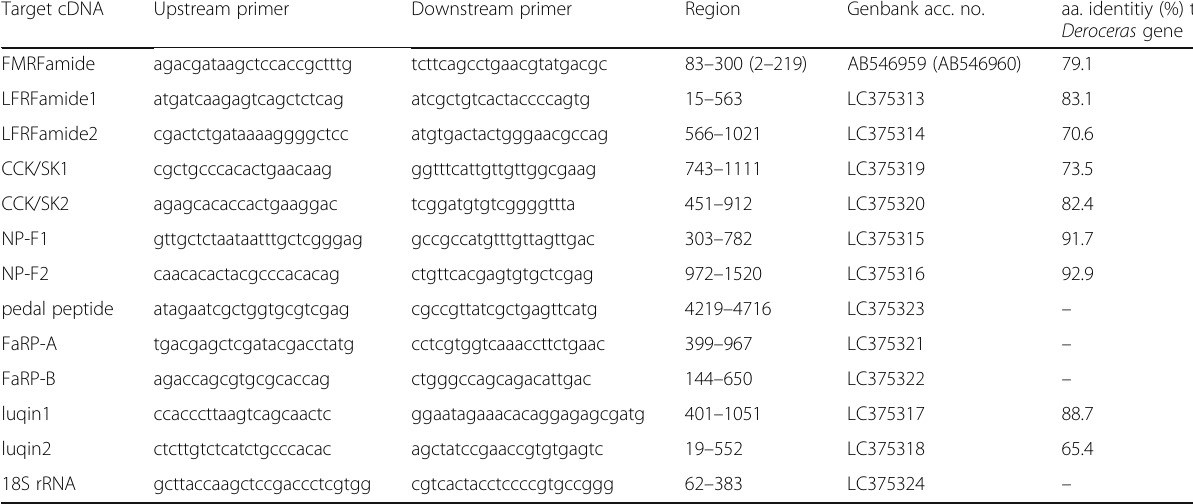
Table 1 PCR primers used for the expression analysis and the preparation of the templates for the cRNA probes used in in situ